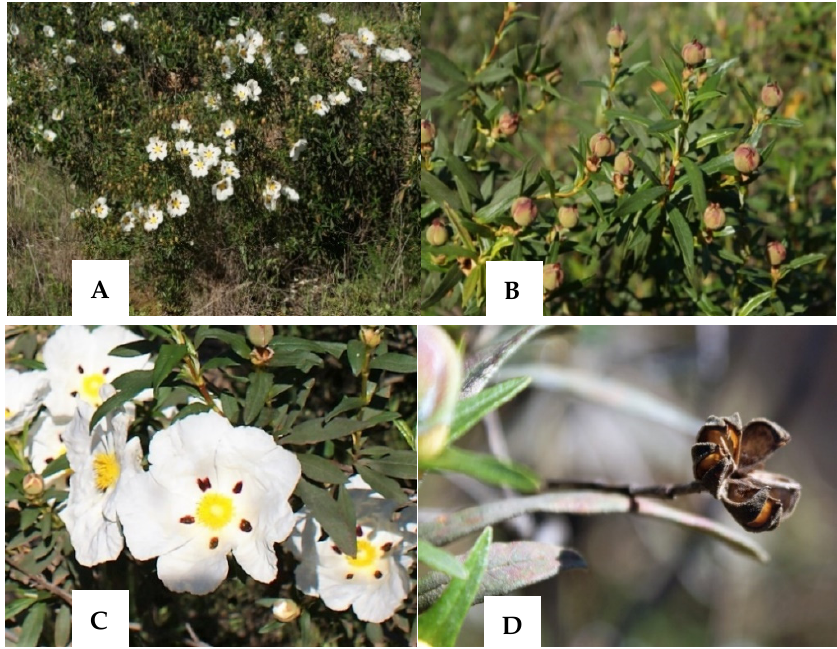
Figure 1. Cistus ladanifer L.: ( A ) whole plant; ( B ) flower buds; ( C ) flowers; ( D ) open cysts. C. ladanifer occurs in a wide range of altitudes, latitudes, climates, and soil types, but it prefers acidic and siliceous soils [16,17] and dry areas with high insolation where it can give rise to large and dense populations. It has high ‐ stress tolerance and, consequently, is competitive under various environmental conditions, including poor soils with low or ‐ ganic matter content, low pH, and high concentrations of trace elements, as well as hydric stress and high temperature and solar radiation [18]. This tolerance may be associated with activity of different isoenzymes, namely superoxide dismutase (SOD), peroxidase (POD), and catalase (CAT) [19], which are the major enzymes involved in detoxification of active oxygen species (AOS) [20]. An evaluation was made of As, Cu, Pb, and Zn con ‐ centrations and activity of the soluble and cell wall ionically bound forms of enzymes SOD, POD, and CAT in leaves of C. ladanifer . The enzymatic activity of these enzymes varied with populations of C. ladanifer , as well as with the seasons of the year, with speci ‐ ficity for each trace element and the location of the enzyme in the cells [19].